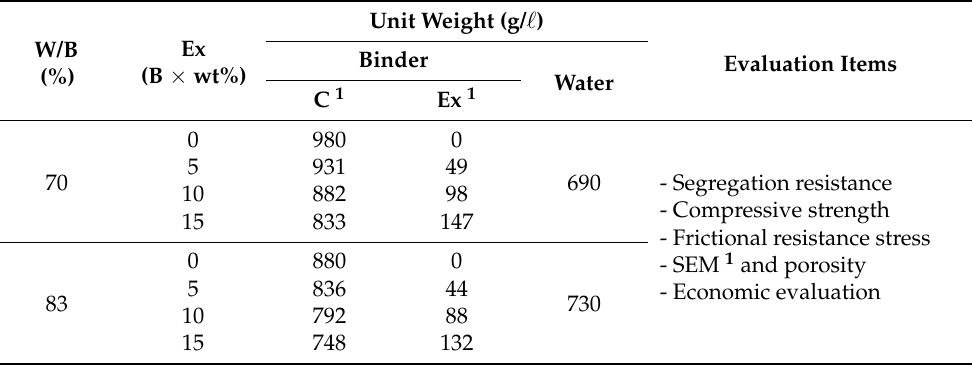
Table 1. Experimental